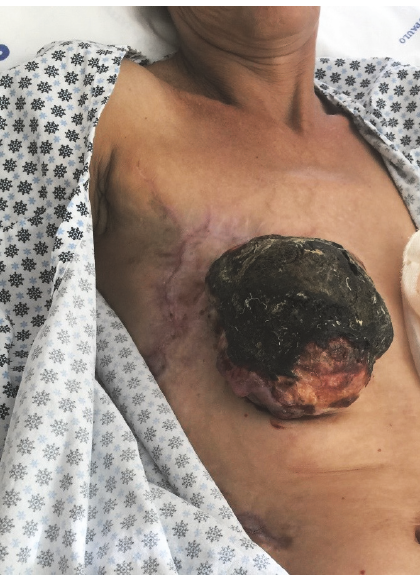
Figure 7: An aspect of the lesion in the readmission of the patient.